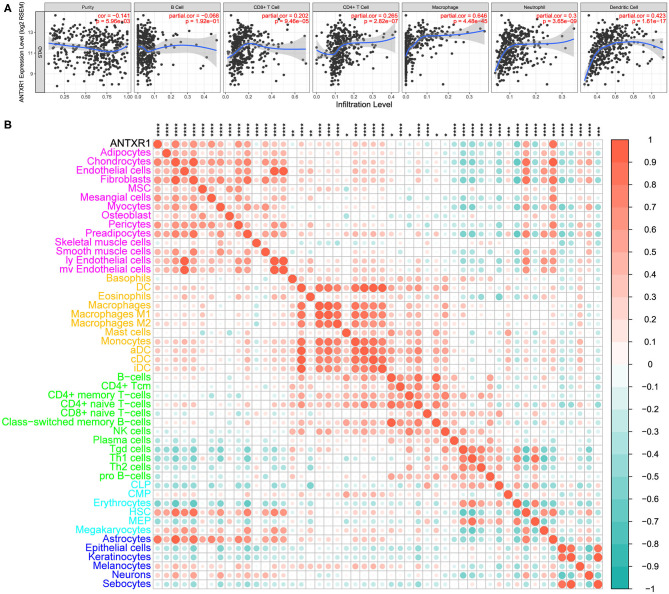
Correlation between ANTXR1 expression and immune and stromal cell infiltration in gastric cancer. (A) Relationship between ANTXR1 expression and six immune cells conducted by TIMER. (B). Corrplot of ANTXR1 expression and 49 cell types calculated by xCell in gastric cancer. *P < 0.05, **P < 0.01, ***P < 0.001, ****P < 0.0001.